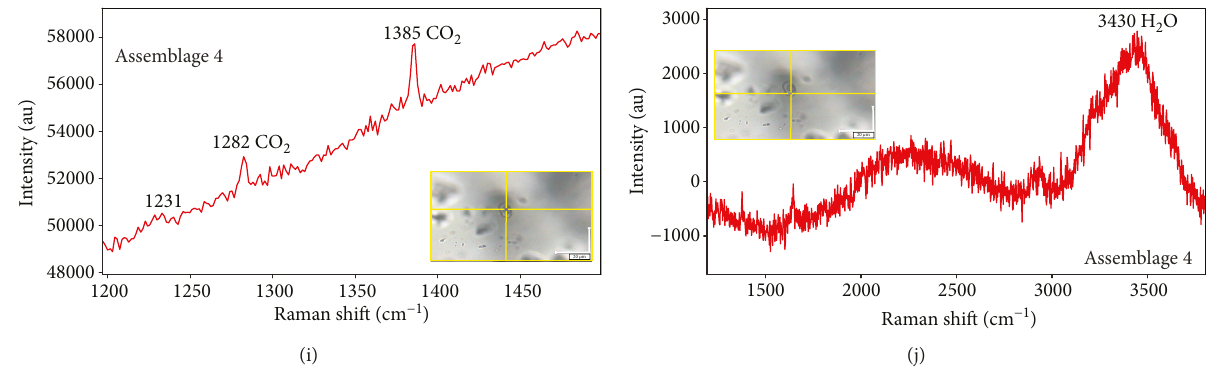
Figure 10: Representative laser Raman spectra of FIs in the Keyue Sb – Pb – Zn – Ag deposit. (a) CO assemblage 2 Mn – Fe carbonate; (b) H spectra of vapor phase in the CO of assemblage 3 quartz; (e) CO FIs of assemblage 3 quartz; (g) CO the C-type FIs of assemblage 3 quartz; (i) CO spectra of liquid phase in the CO